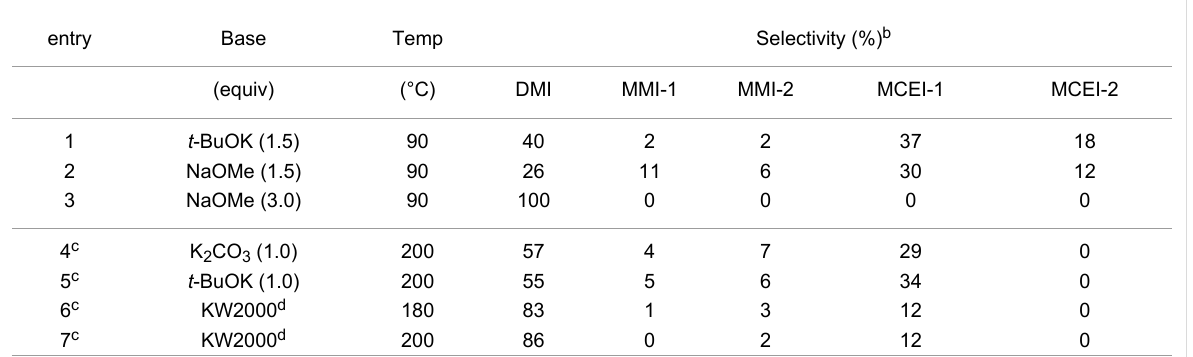
Table 4: Synthesis of dimethyl isosorbide (DMI) by DMC chemistry. a